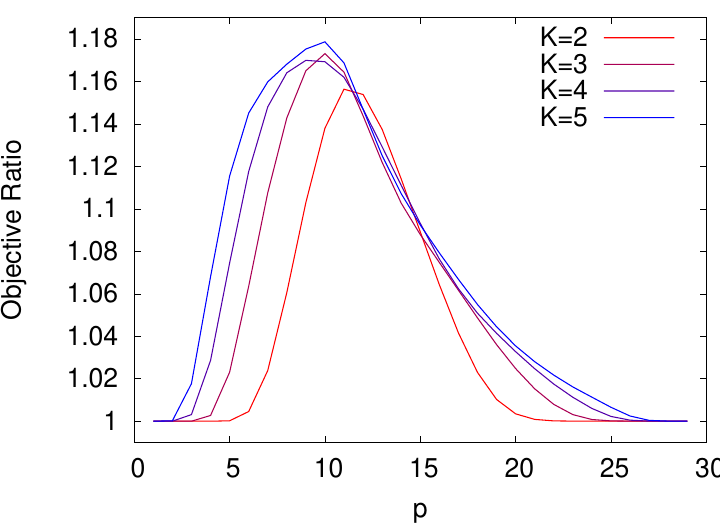
Figure 3 Experiment 2: Ratio of average objective values of solutions based on classic and locally and budgeted